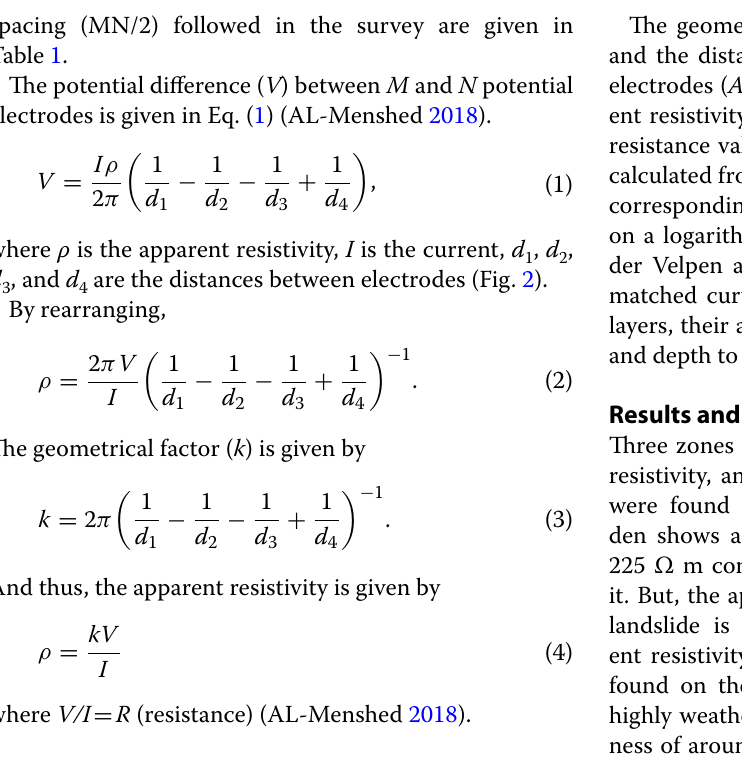
where V/I R (resistance) (AL-Menshed 2018). =